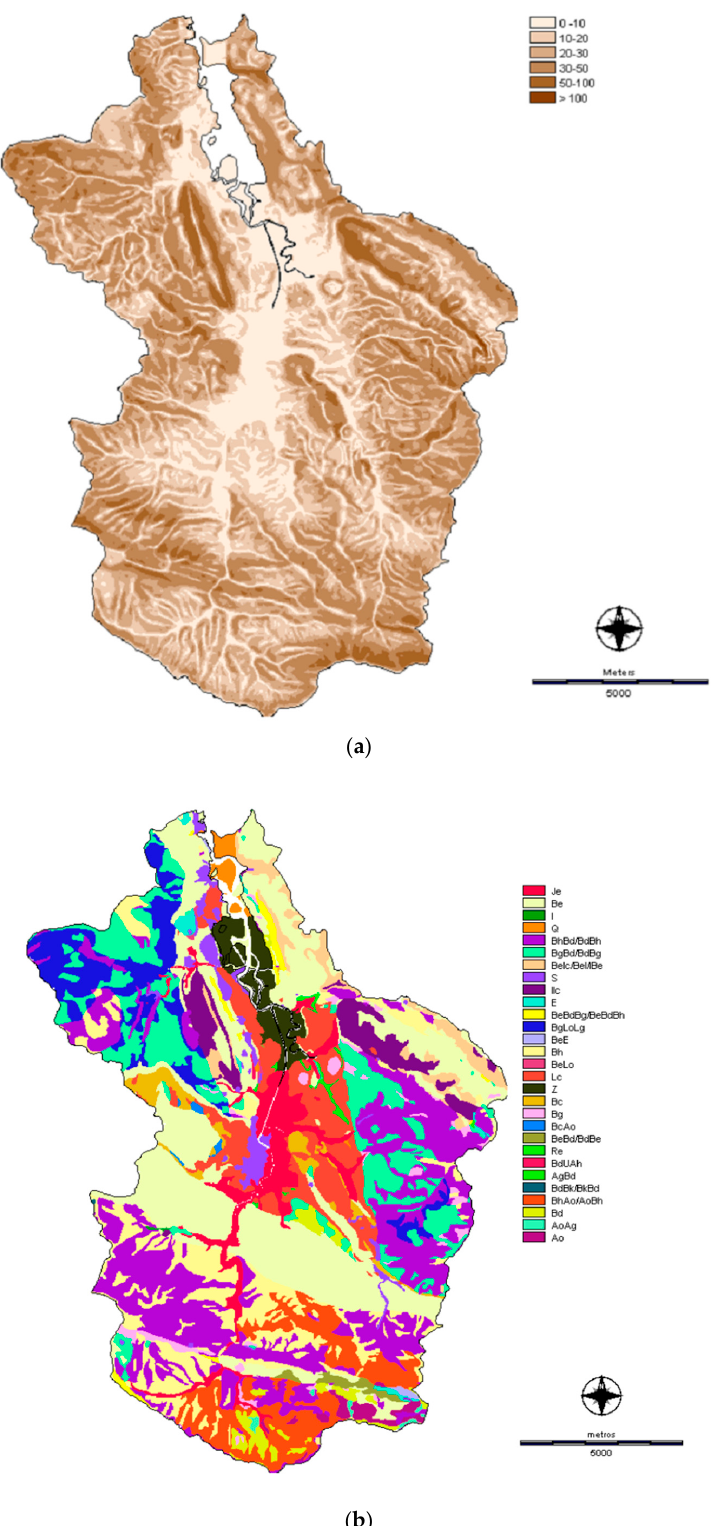
Figure 2. Maps of the Oka River Basin. ( a ) slopes map; ( b ) soils map.